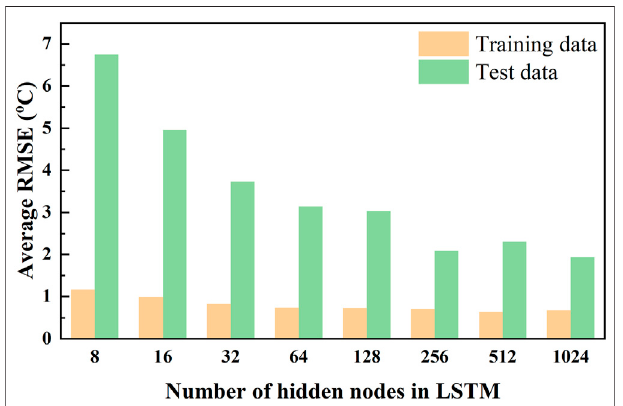
FIGURE 8 | Distribution of the absolute errors on training